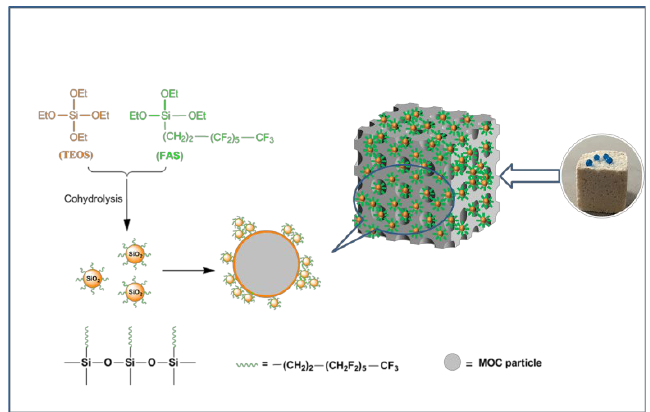
Figure 8. Triethoxy-1H, 1H, 2H, 2H-tridecylfluoro-n-octylsilane (FAS), and tetraethyl orthosilicate (TEOS) co-hydrolysis mechanism.